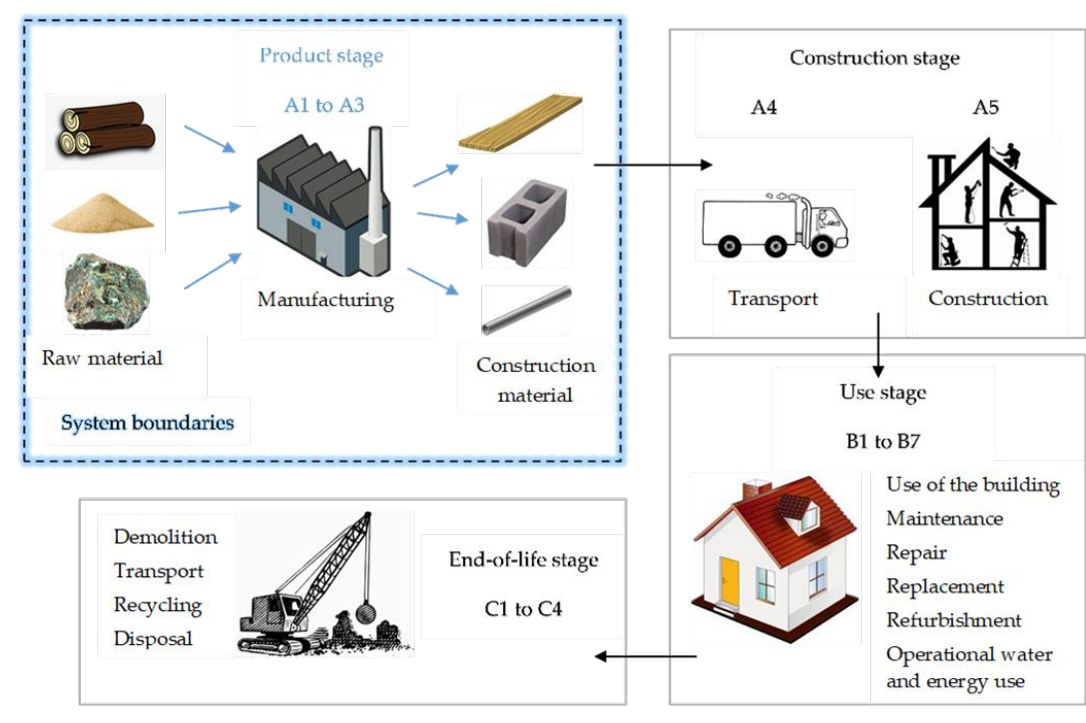
Figure 5. System boundaries. Table 1. Description of construction composition and databases selected for the assessment of the building within life cycle stages from A1 – A3.